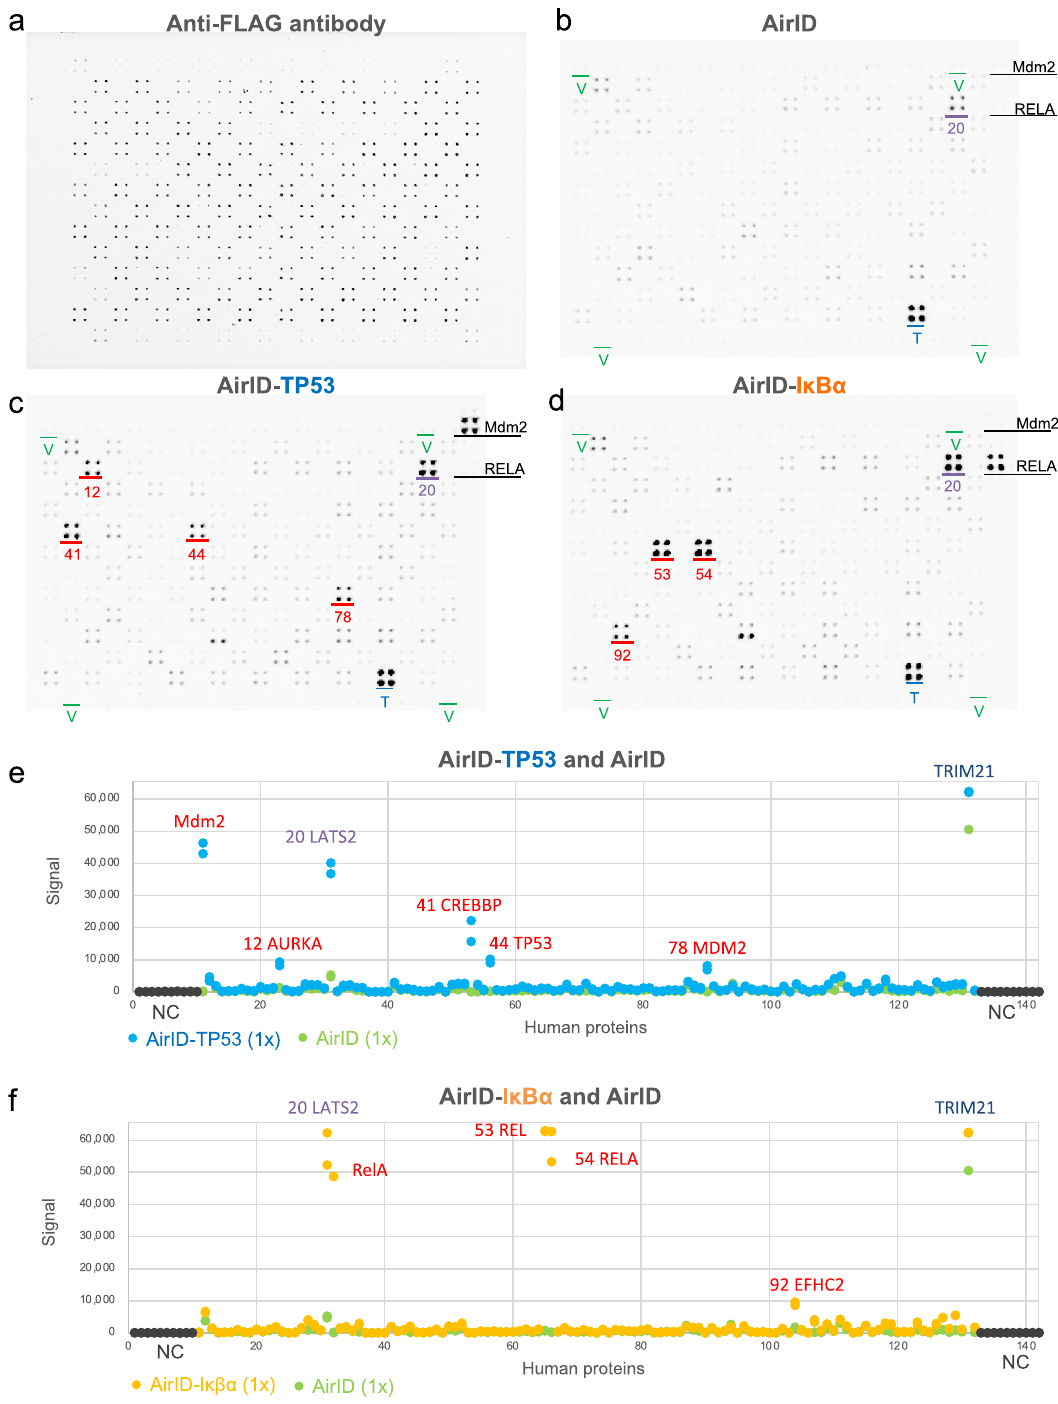
Figure 3. Validation of CF-PPiD using a diversity protein array. ( a ) The identity of the FLAG-GST tagged proteins spotted on the diversity protein array was confirmed using a fluorescently labelled anti-FLAG antibody. ( b ) The image of the PPI screening between AirID and the proteins on the diversity protein array. ( c ) The image of the PPI screening between AirID-TP53 and the proteins on the diversity protein array. ( d ) The image of the PPI screening between AirID-IκBα and the proteins on the diversity protein array. ( e ) The dot-blotting graph from scan data of the PPI screening using AirID or AirID-TP53 protein. ( f ) The dot-blotting graph from scan data of the PPI screening using AirID or AirID-IκBα fusion protein. The dots represent the intensity of 1 × beads spots. Positive spots are labelled in red. The spots of TRIM21, which interacted with antibody IgG, are labelled in dark blue. The spots of LATS2, which interacted with AirID alone, are labelled in purple. The numbers on the figures a-d indicate a clone No. of the spots. Green character V indicates Venus spots. Source data are provided as a Source data